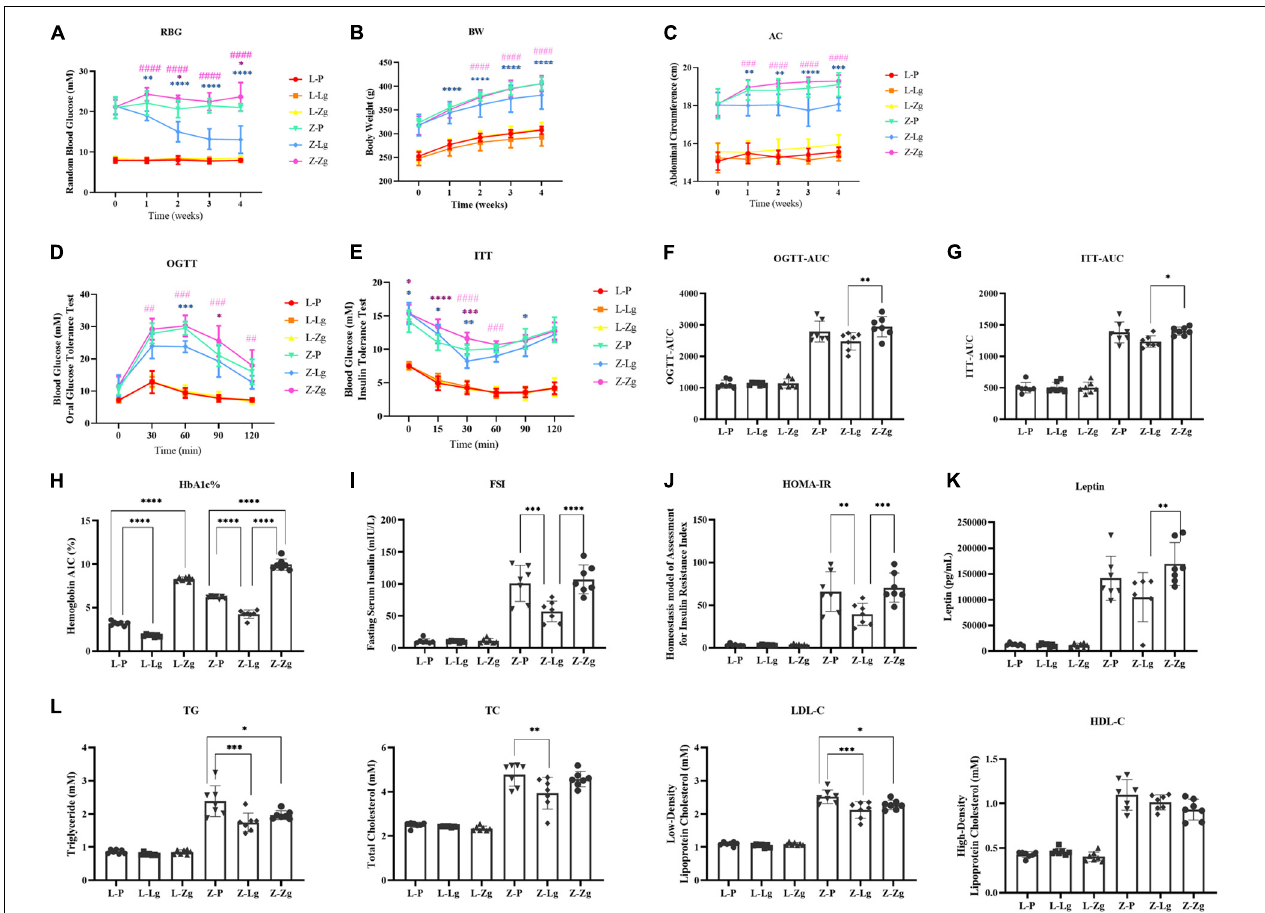
FIGURE 2 | GMT changes glycolipid metabolism disorder in ZDF recipient rats. (A) Random blood glucose [RBG; Time: F ( 4 , 24 ) = 5.870, P = 0.0019; Group: F ( 5